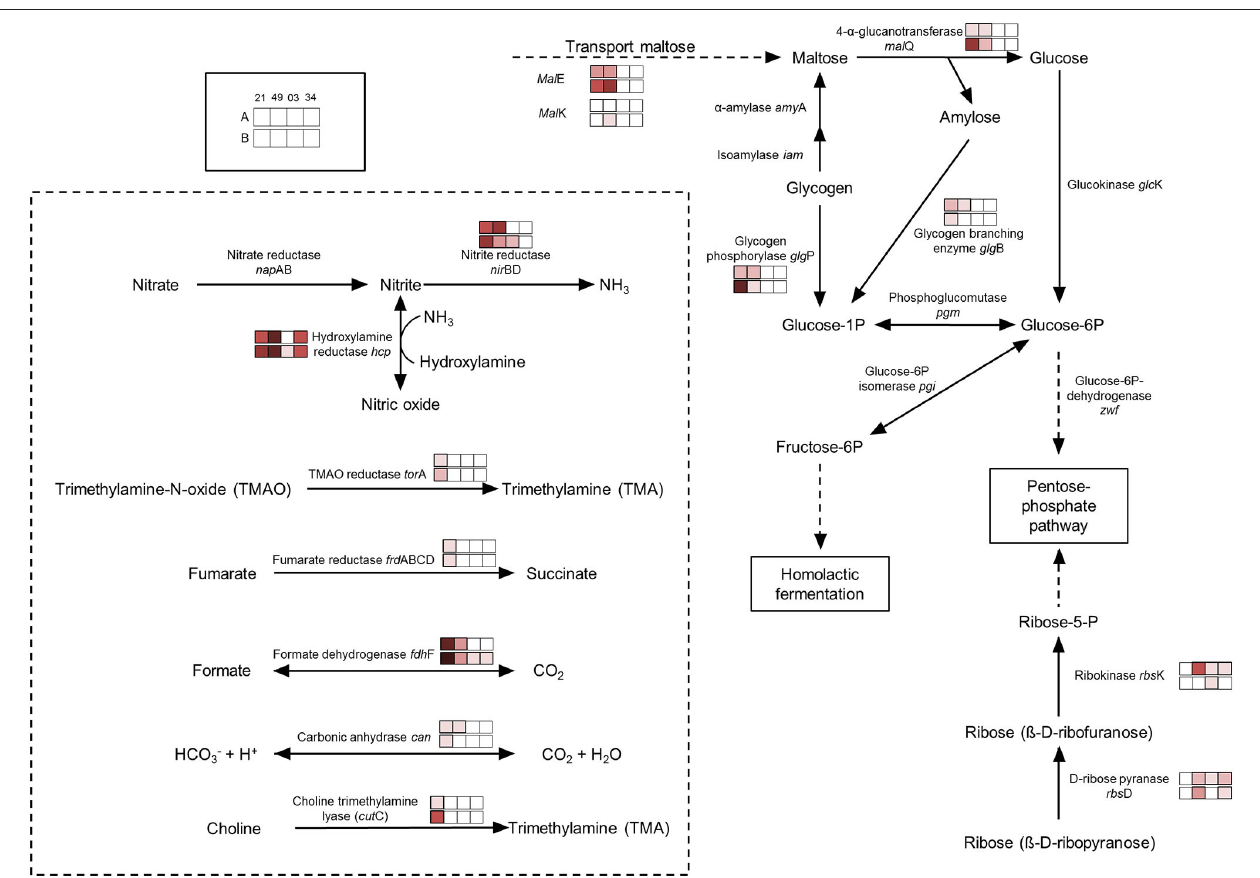
FIGURE 4 | Regulation of enzymes observed under anaerobic conditions. The colored boxes display the observed regulation for each strain. Each row of the colored boxes corresponds to one comparison: A. air_vs._N 2 , B. O 2 N 2 _vs._N 2 . Each column of the colored boxes corresponds to one strain: P. carnosum 21 = TMW 2.2021 T , 49 = TMW 2.2149, P. phosphoreum 03 = TMW 2.2103, 34 = TMW 2.2134. Color code is represented